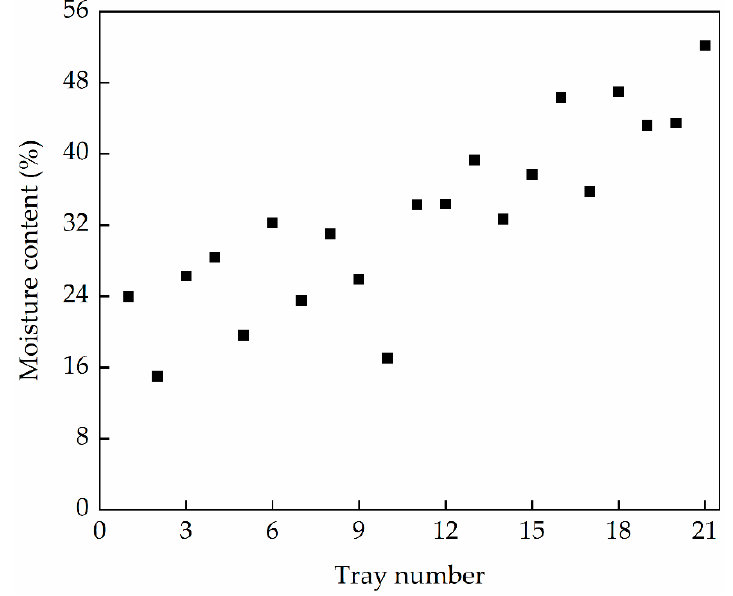
Figure 5. Momentary moisture content of leaves along the dryer (trays 1–21) in the ISD after 68 h of drying.